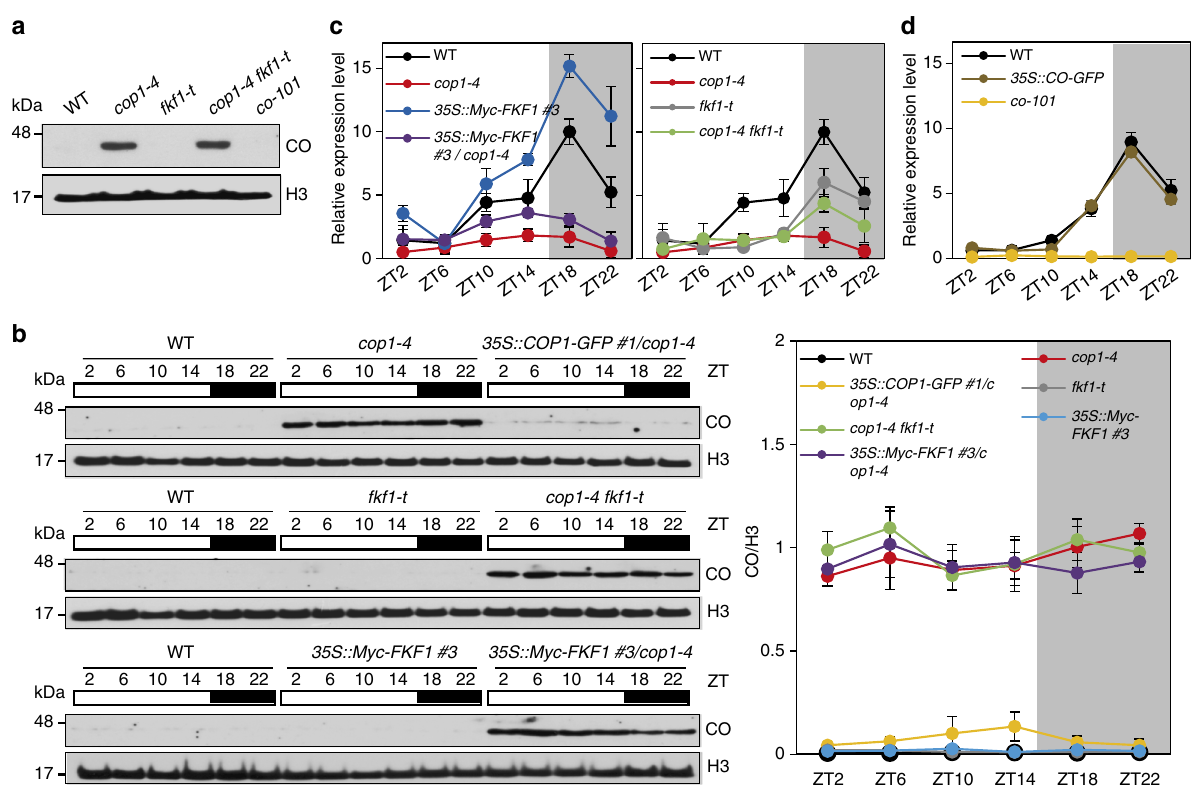
Fig. 2 CO accumulates to high levels in the cop1-4 background regardless of FKF1. a CO accumulation at ZT15 in 10-day-old seedlings under LD. b CO accumulation in various plants. Plants were grown for 10 days under LD and harvested every 4 h over the course of a day. Nuclear protein-enriched fractions were immunoblotted using an anti-CO antibody ( α -CO) to measure CO levels and an anti-H3 antibody ( α -H3) for a loading control. Data are means ± s.d. from at least three biological repeats. c Relative abundance of CO mRNA during a day in 10-day-old seedlings. d Native CO mRNA levels during a day in 35S::CO-GFP transgenic plants. To detect the native CO mRNA, a speci fi c primer was designed from the 3 ′ -UTR region of the CO mRNA sequence. c , d For RT-qPCR, the relative expression level of each gene was normalized to the mRNA level of ACTIN (AT3G18780) as a loading control. Data are means ± s.d. from three biological